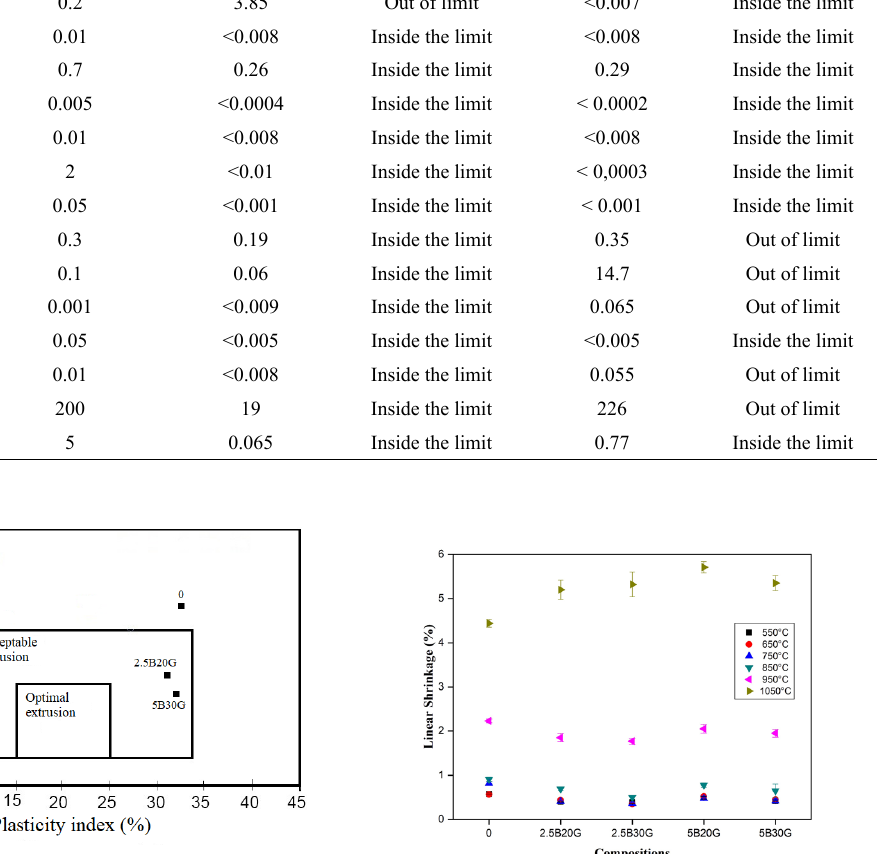
Figure 4. Extrusion prognostics.